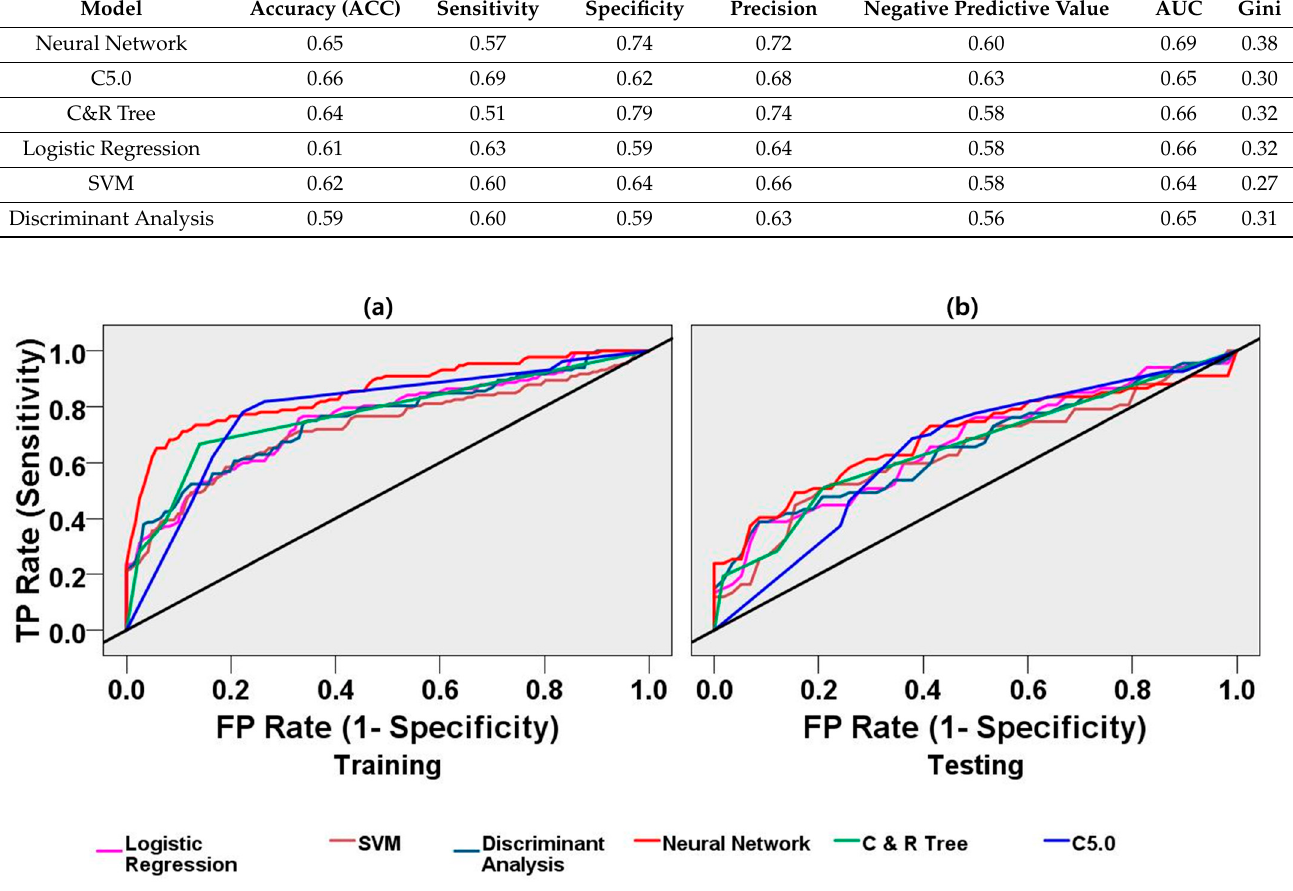
Figure 5. Receiver operating characteristic (ROC) curves for logistic regression, support vector machine (SVM), discriminant analysis, neural network, C&R Tree, C5.0 machine learning models for classification of the stroke group and the control group. ( a ) ROC curve using the EMG training datasets. The neural network model classified the training dataset with the highest AUC (85%) and accuracy (80%); ( b ) ROC curve using the EMG test datasets. The neural network model classified the test dataset with the highest AUC (69%) and highest accuracy (65%). The diagonal black line is the reference line.